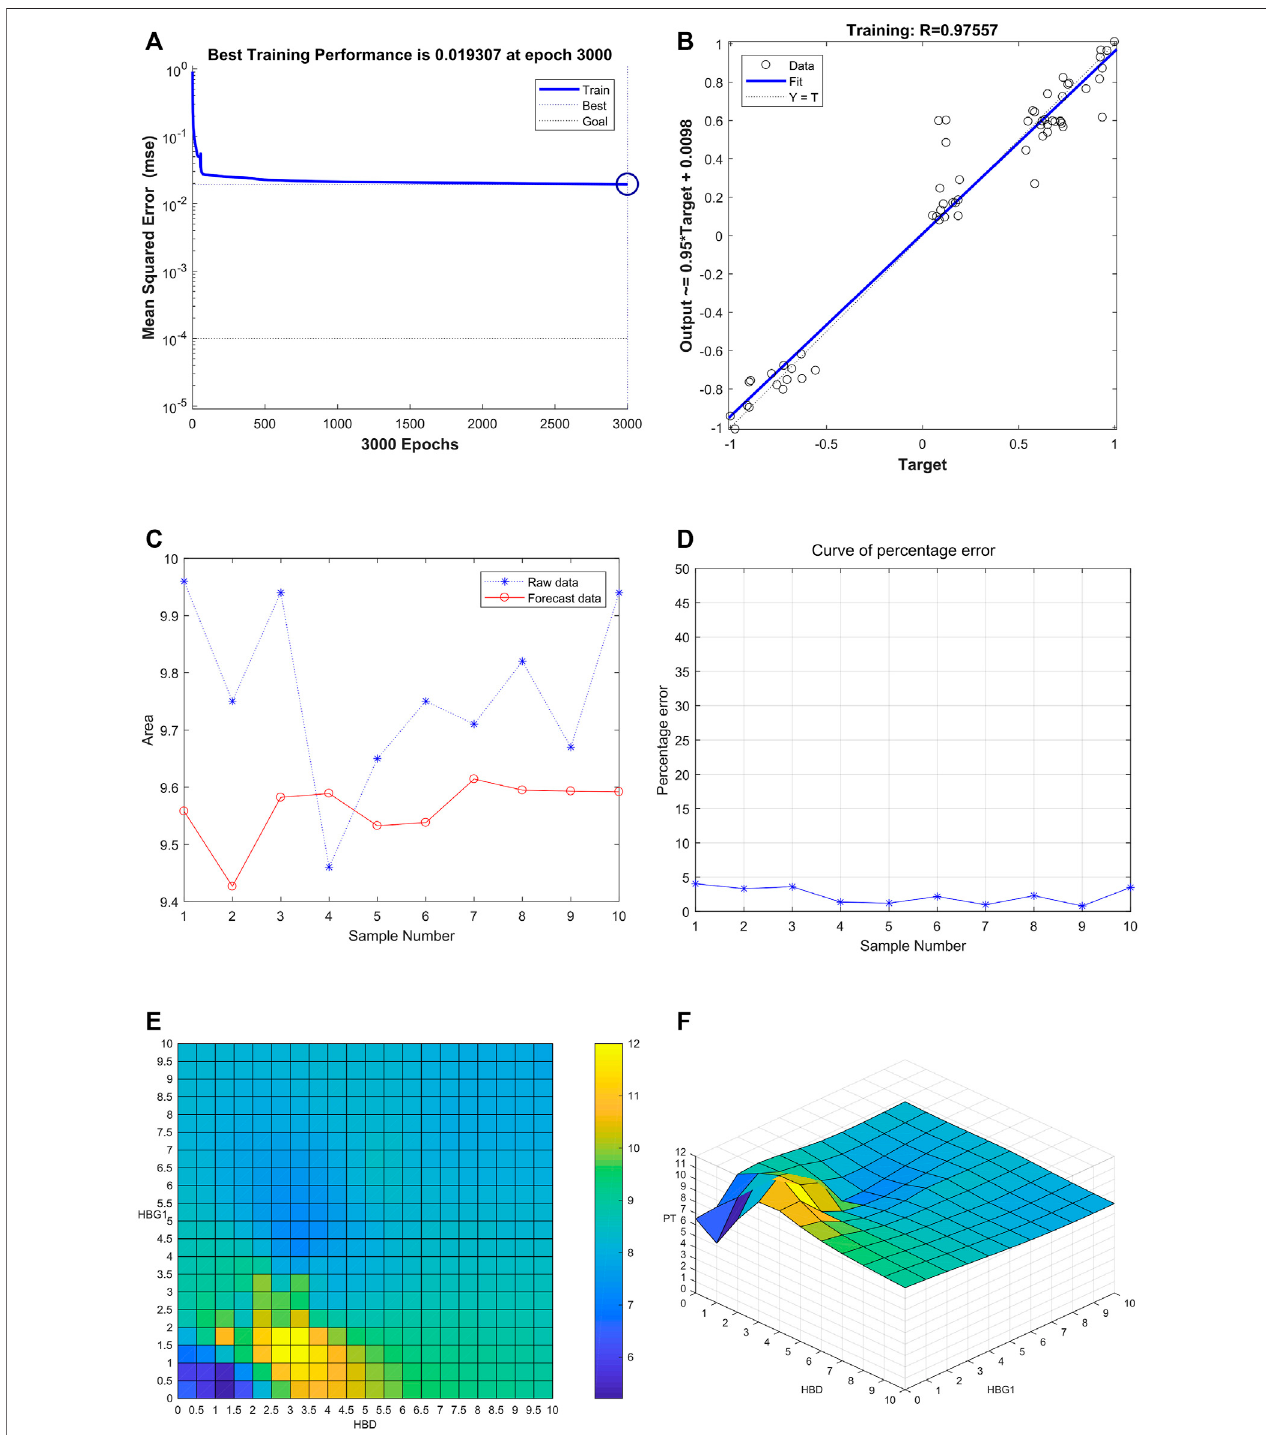
FIGURE 8 | Successful construction of the BP neural network among HBG1, HBD and PT. (A) After training of 3000 epochs, the best training performance is 0.019307. (B) There exists a signi fi cant interaction between HBG1, HBD, and PT. Also, the correlation coef fi cient is 0.97557. (C) Variation tendency between the raw dataandforecastdatawasclose. (D) Curveofthepercentageerrorwasalsodrawn,andthepercentageerrorswerealllessthanthe5%. (E,F) Quantitativepredictionsof HBG1 and HBD for the PT in the cubic spline interpolation were performed, and when 2.0 < HBD < 5.0, 0 < HBG1 < 3.5, the value of PT is larger.